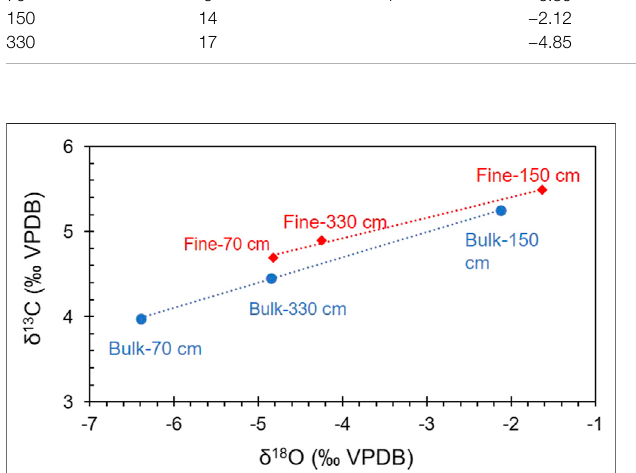
FIGURE 5 | Comparison of the δ 18 O ( ‰ VPDB) and δ 13 C ( ‰ VPDB) values of the fi ne-grained and bulk carbonates in core GZLC15-1 from Guozha Co.